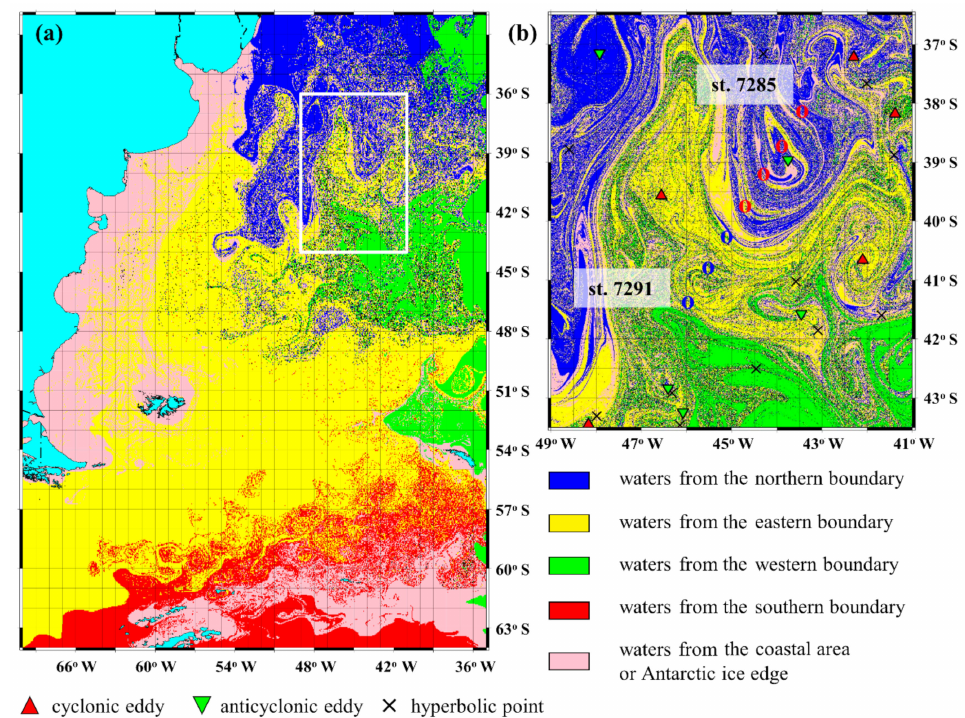
Figure 2. ( a , b ) shows the backward-in-time Lagrangian origin map on 12 January 2022. Blue color denotes water particles from the northern edge of the map from the subtropical region, yellow color denotes waters from the western edge of the map from the Drake Passage, red color denotes water from the southern edge of the map (Antarctica), green color denotes water from the eastern border of the map. Pink color denotes water particles that “touched” the shore or Antarctic ice edge and spread from the shore or the